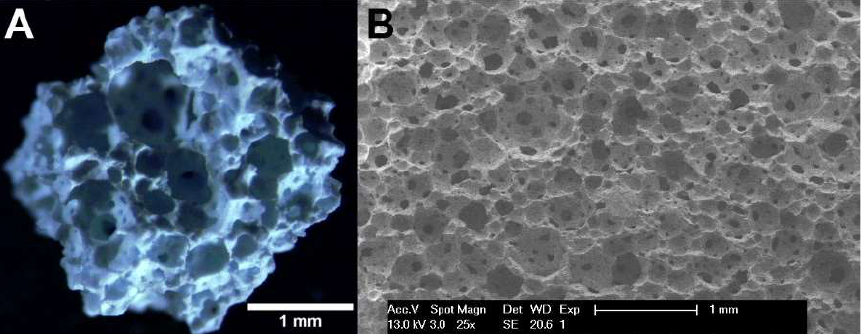
Figure 1. ( A ) A stereomicroscopy image of a PermaBone ® hydroxyapatite granule. ( B ) A scanning electron microscopy image of pre-granulated PermaBone ® hydroxyapatite.